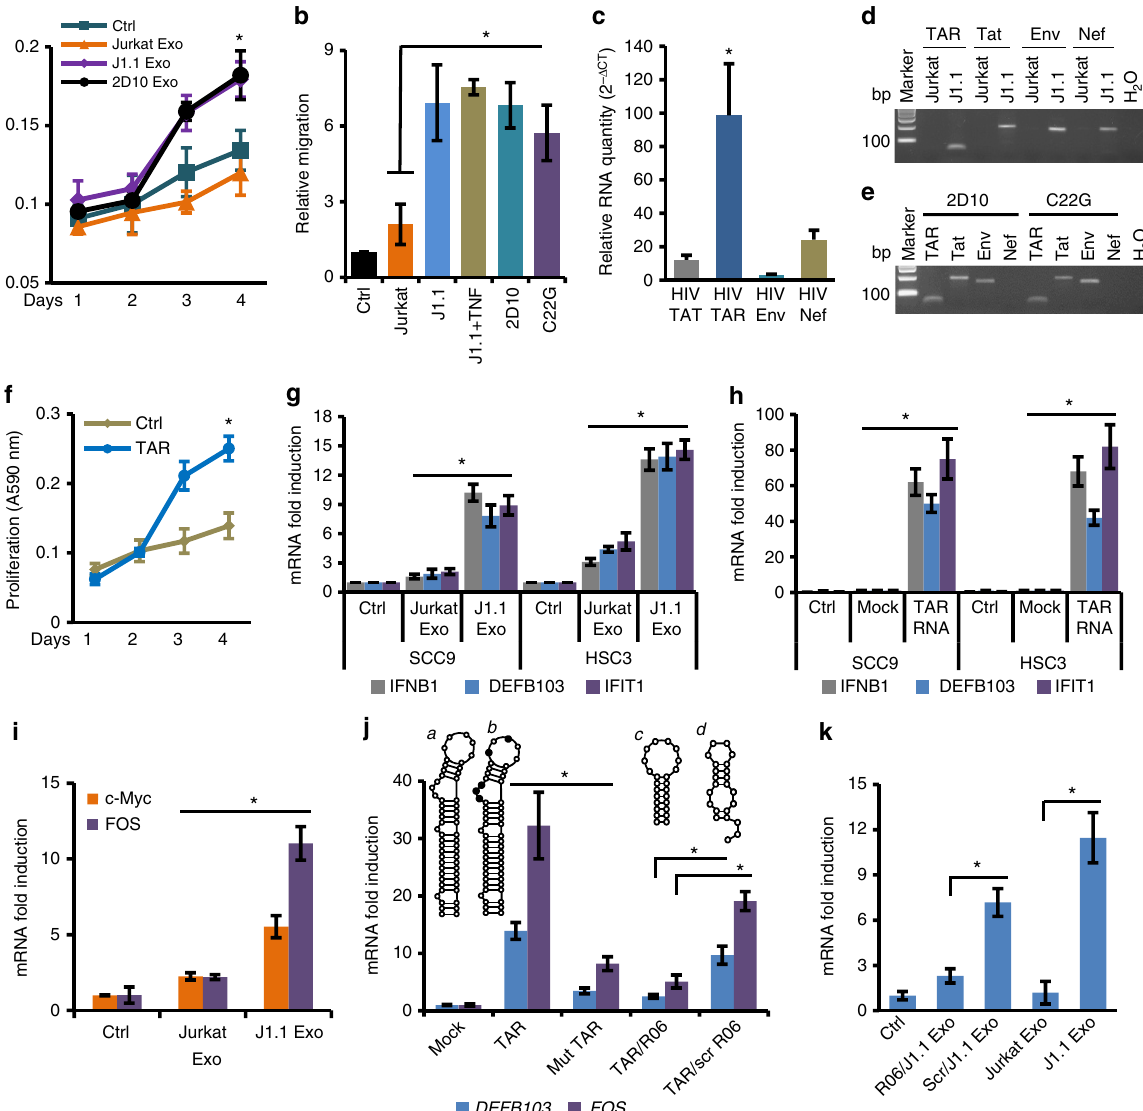
Fig. 3 TAR RNA contributes to the pro-tumor function of HIV-positive exosomes. a HSC3 cells treated with J1.1, 2D10 and Jurkat cell exosomes (4.1×10 9 ml − 1 ) for cell proliferation. Error bars,±s.d., n = 3, * p< 0.05, one-way ANOVA (days 3 and 4). b HSC3 cells treated with J1.1, TNF α -activated J1.1 (J1.1 + TNF), 2D10, C22G, and Jurkat cell exosomes (4×10 9 ml − 1 ) for cell migration. Ctrl, serum-free control. Error bars,±s.d., n = 3, * p< 0.05, F -test. c qRT-PCR of HIV RNA in J1.1 cell exosomes. Error bars,±s.d., n = 3, * p< 0.02, F -test. d PCR amplimers in c . bp, DNA marker size. e RT-PCR of 2D10 and C22G cell exosomes. H 2 O, mock PCR. f Proliferation of HSC3 cells transfected with synthetic TAR RNA (1 µ gml − 1 ). Error bars,±s.d., n = 3, * p< 0.05, one-way ANOVA (days 3 and 4). Ctrl mock transfection. g qRT-PCR of IFNB1 , DEFB103, and IFIT1 mRNA on cells treated with Jurkat and J1.1 cell exosomes (4×10 9 ml − 1 ) for 18h. Exo, exosomes. Error bars,±s.d., n = 3, * p <0.05, F -test. h qRT-PCR of SCC9 and HSC3 cells transfected with synthetic TAR RNA (1 µ gml − 1 ) for 18h. Error bars,±s.d., n = 3, * p< 0.05, F -test. Mock, mock transfection; ctrl, un-transfected. i qRT-PCR for c-Myc and FOS mRNA in HSC3 cells treated with exosomes (4×10 9 ml − 1 ) for 18h. Error bars,±s.d., n = 3, * p <0.05, F -test. j qRT-PCR of FOS and DEFB103 mRNA in HSC3 cells transfected with TAR RNA (TAR, a ), mutant TAR (Mut TAR, b ), co-transfected with R06 aptamer (TAR/R06; c ) or scrambled RNA (TAR/scr R06; d ) for 18h. Error bars,±s.d., n = 3, * p <0.05, F -test. k qRT-PCR of DEFB103 in HSC3 cells treated with J1.1 exosomes transfected with R06 or scrambled aptamer (Scr) for 18h. Error bars,±s.d., n = 3, * p< 0.05, F -test. Jurkat and J1.1